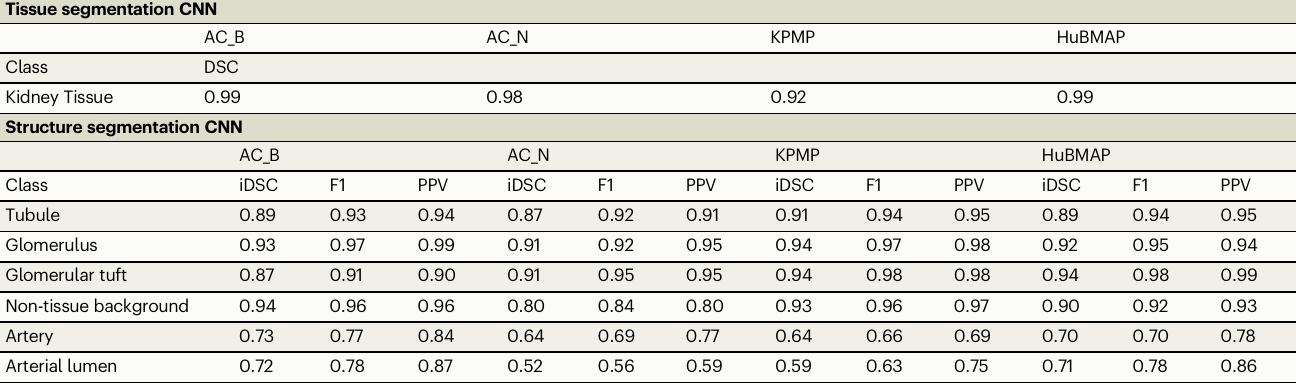
Table 1 | Performance metrics for the tissue segmentation convolutional neural network (CNN) and structure segmentation CNN Tissue segmentation